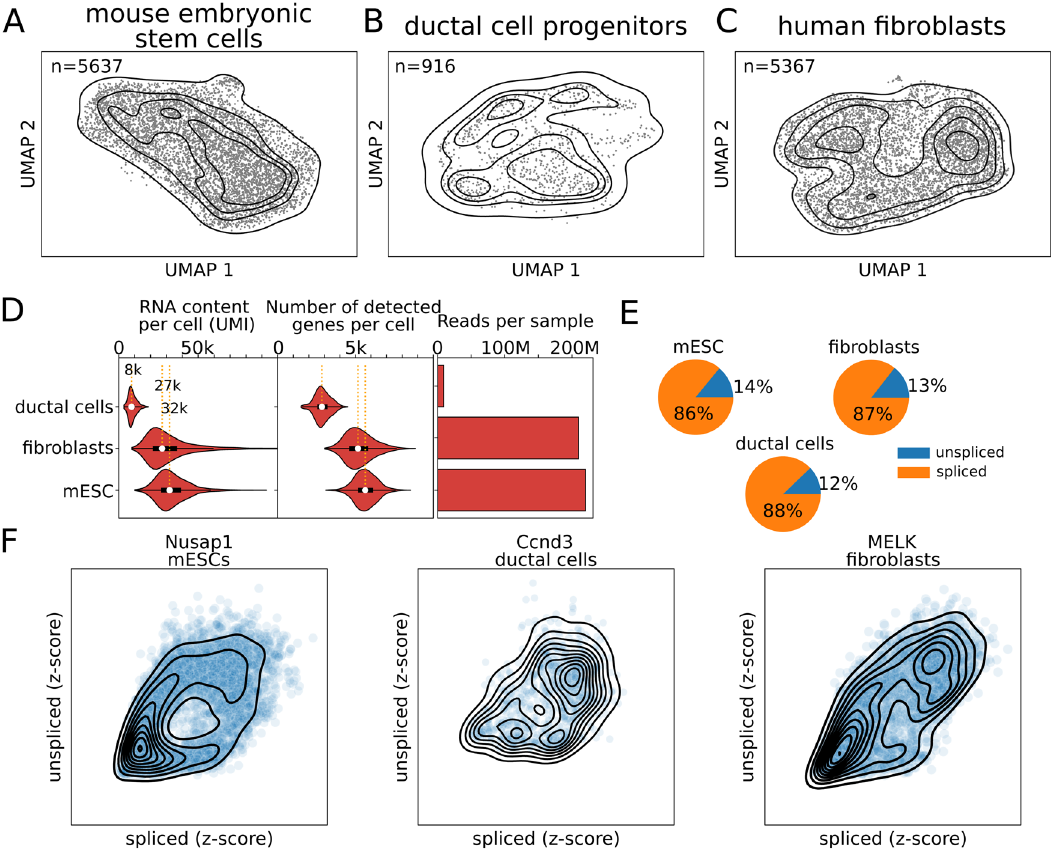
Fig. 1 Single-cell RNA-sequencing data show the RNA velocity patterns. UMAP projections for mouse embryonic stem cells ( A ), ductal cell progenitors ( B ), and human fi broblasts ( C ). D Distribution of RNA content (UMI), number of genes per cell, and the total number of reads (unspliced + spliced) for each sample. White dots represent the median. Boxes represent 50% of the data and whiskers 99%. E . Fractions of spliced and unspliced reads in the three datasets. F Examples of the unspliced-spliced patterns for Nusap1 , Ccnd3 , and MELK in mouse embryonic stem cells, ductal cells, and human fi broblasts,